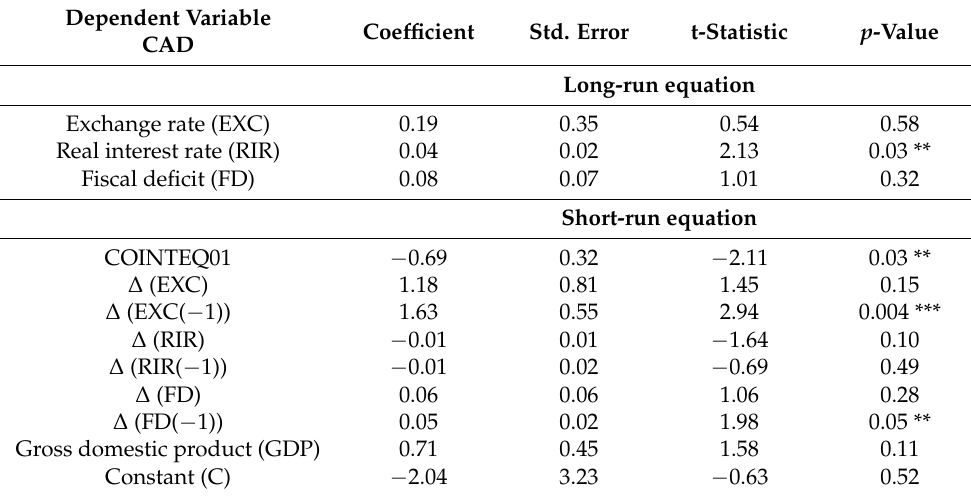
Table 11. Findings of panel auto-regressive distributed lag (ARDL) for upper-middle-income economies (UMIE).